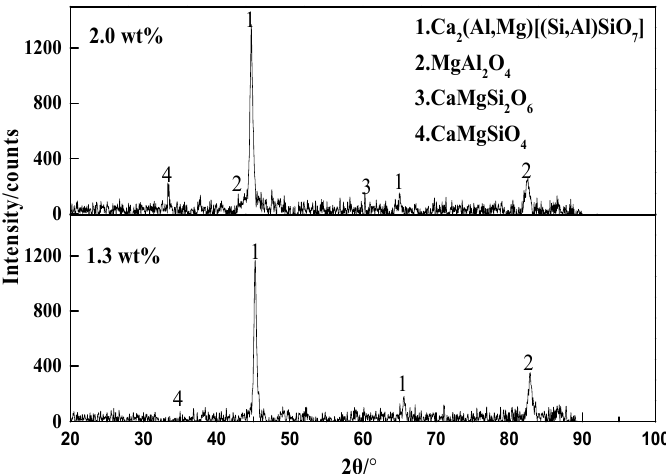
Figure 17. X-ray di ff raction patterns of primary slag. Figure 17. X-ray diffraction patterns of primary slag. Figure 17. X-ray diffraction patterns of primary slag.